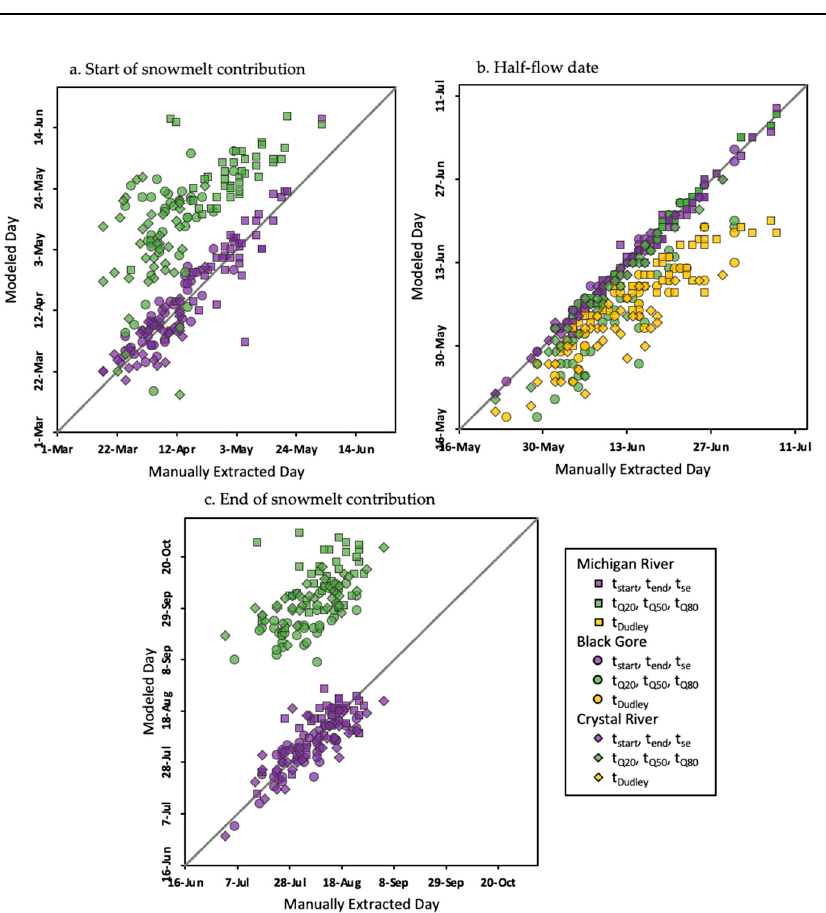
Figure 2. Comparison of the timing metrics for the ( a ) start, ( b ) half-flow, and ( c ) end of the snowmelt contribution to the streamflow.